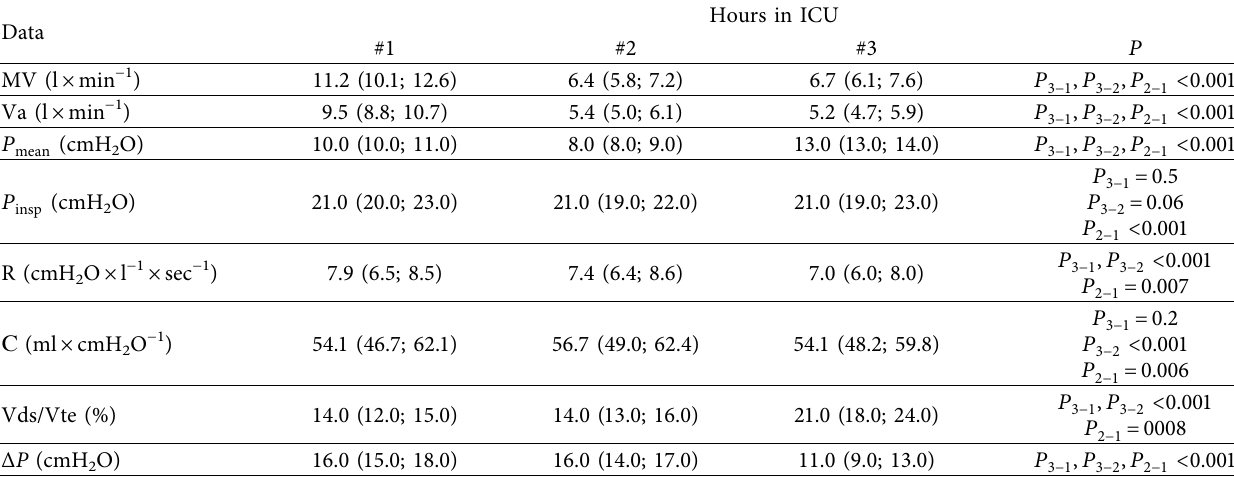
Table 1: Changes in respiratory parameters in patients from the interventional group at three hours of the study, median (25 th ; 75 th percentiles), n � 95.